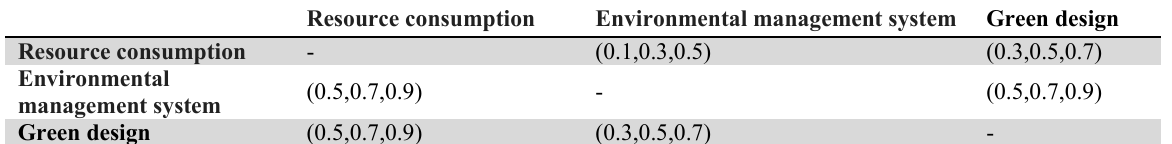
The relative importance of the sub-criteria of the environmental benefits criterion when the sub-criteria of contamination production is under control